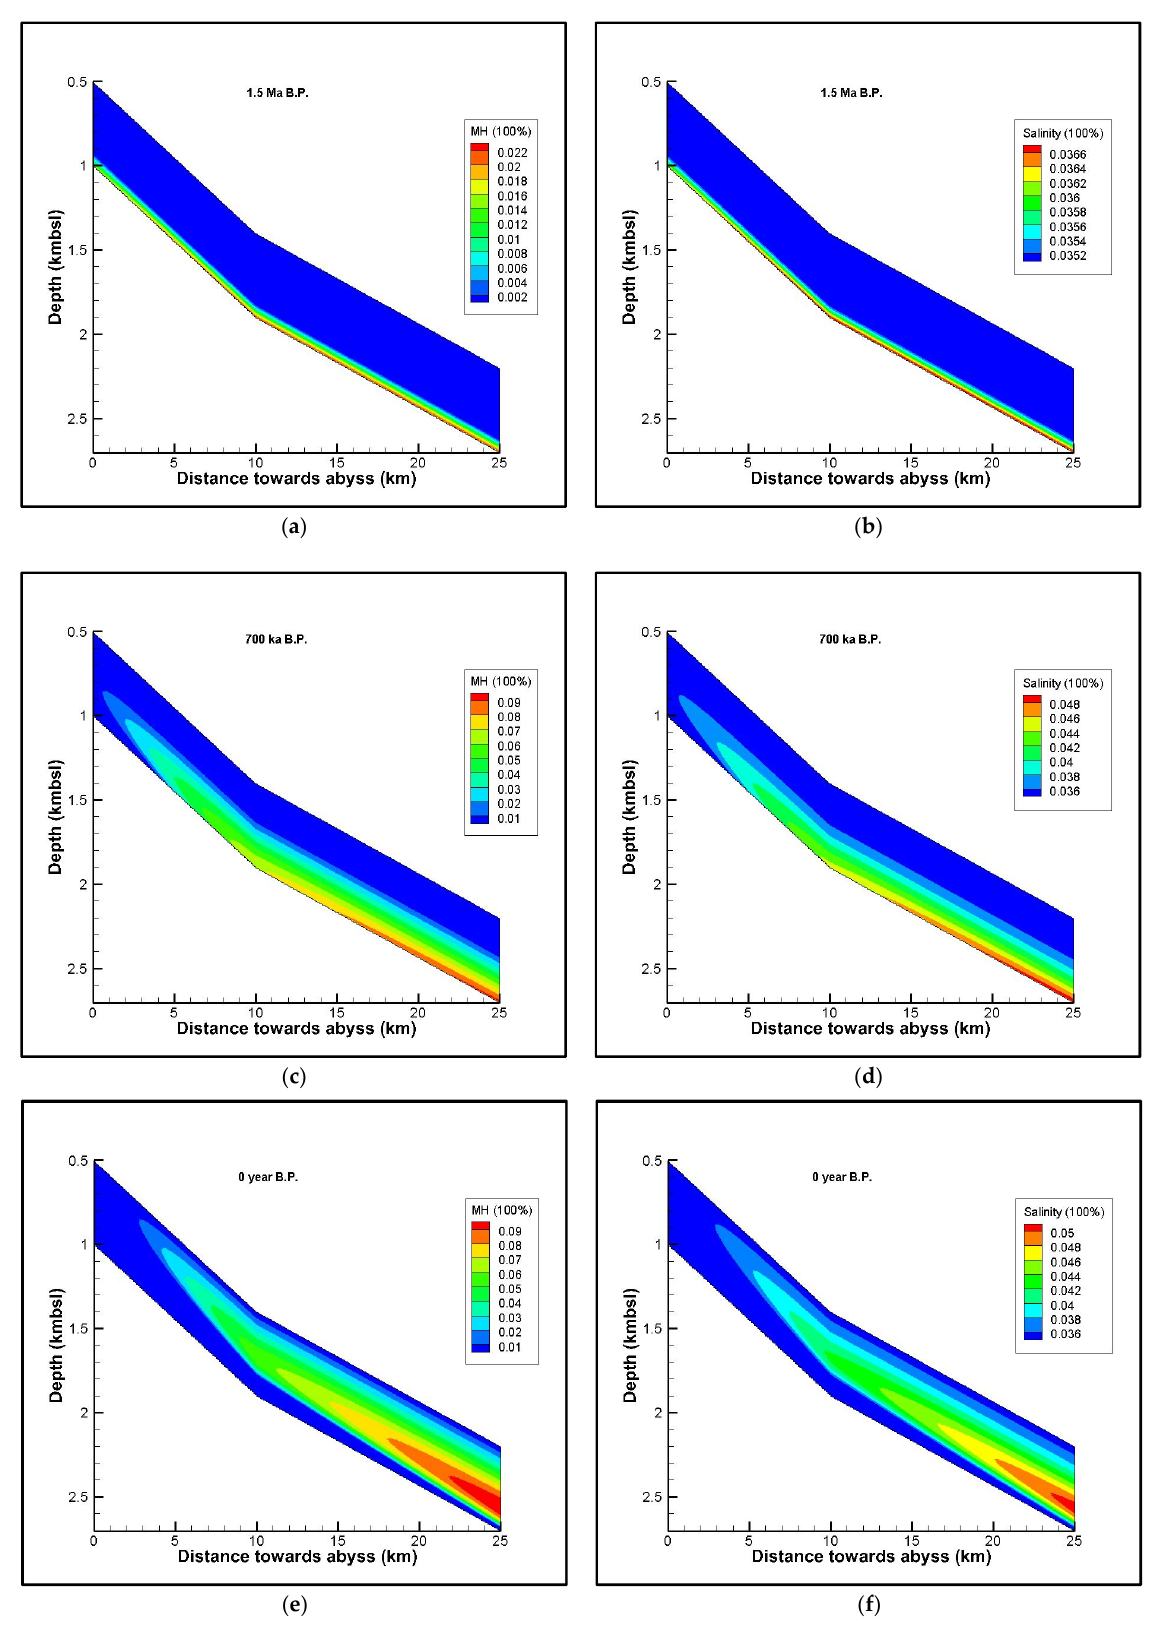
Figure 9. Evolution of MH reservoir in the three typical scenarios of 1.5 Ma B.P. ( a ), 700 ka B.P. ( c ), and present ( e ), and corresponding pore salinity changes ( b , d , f ).